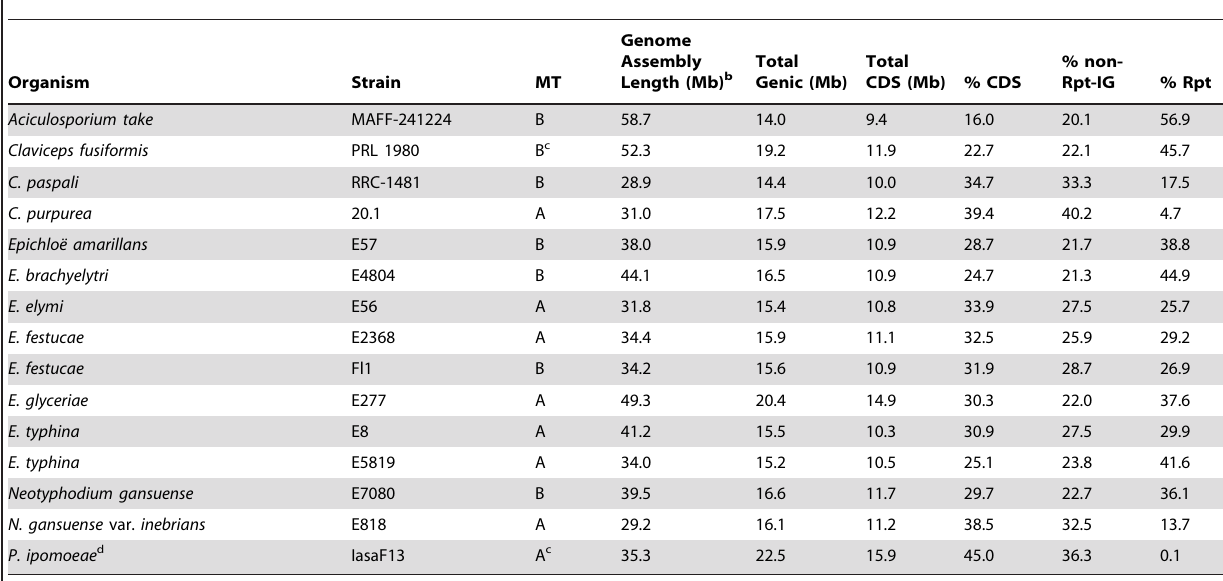
Table 2. Genic and repeat DNA contents of sequenced genomes. a